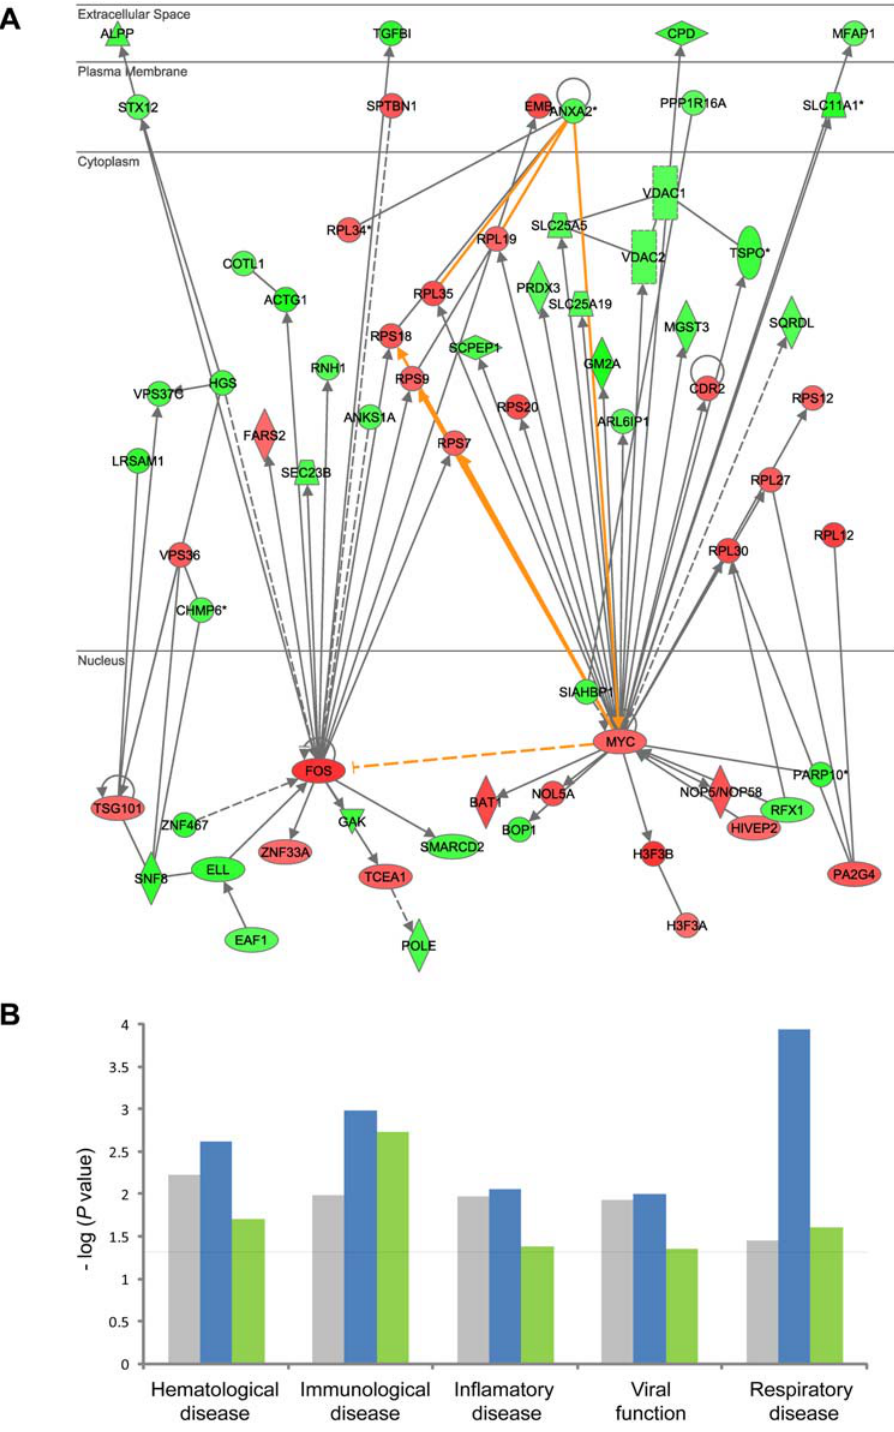
Figure 4. Functional analysis of differentially expressed genes. (A) Differential expression of the FOS and MYC networks and enriched disease classes. The Ingenuity Pathways Knowledge Base (IPKB) was used to generate networks of interacting genes that are overrepresented in the set of transcripts differentially expressed (based on a 1% FDR cutoff) between the urban and rural samples. The top two networks are focused on the FOS and MYC transcriptionfactors,andevery one ofthe genes thatthe IPKB indicateasinteractingeithergeneticallyorbiochemically are differentially expressedin this comparison. Network connectivity is indicated as solid edges for direct interactions, and dashed edges for indirect interactions. Transcripts are displayed in green for down-regulated and red for up-regulated, while cellular compartments in which the gene products are localized are also indicated. Gold edges highlight shared interactions. The list of genes, their fold change and P values are listed in Table S3. (B) Overrepresentation of disease classes affected by differentially expressed genes. Some of the Ingenuity Knowledge Database disease bio-function categories enriched ( P , 0.05) in differentially expressed transcripts (1% FDR) in the three lifestyle pairwise comparisons (grey, urban vs . rural; blue, nomadic vs . urban; green, nomadic vs . rural). Fisher’s exact test was used to calculate the P value associated with the probability that the number of genes in each biological function and/or disease assigned to that data set is greater or less than expected by chance given the numbers of genes expressed in leukocytes. doi:10.1371/journal.pgen.1000052.g004 PLoS Genetics |